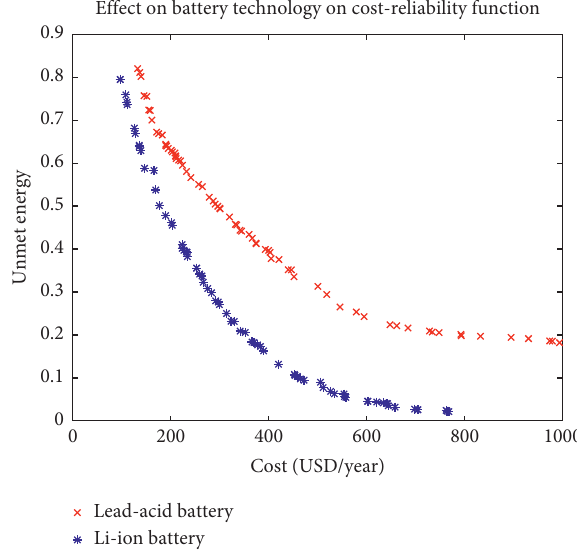
Figure 4: The effect of battery types on the cost-reliability rela- tionship of a hybrid wind/solar system developed for a detached house of 5 people (PV panels, tilt angle: 65 ° toward south; wind turbine hub height: 12m; using measured weather data from Holt; yearly consumption: